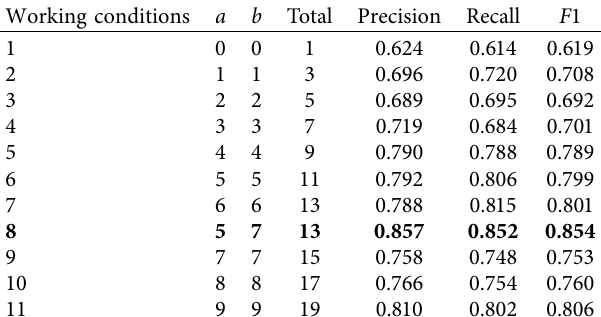
Figure 9: Statistical distribution of the ground loss values, V Table 4: Comparison of the effect of changing the number of rings used in the correlation.